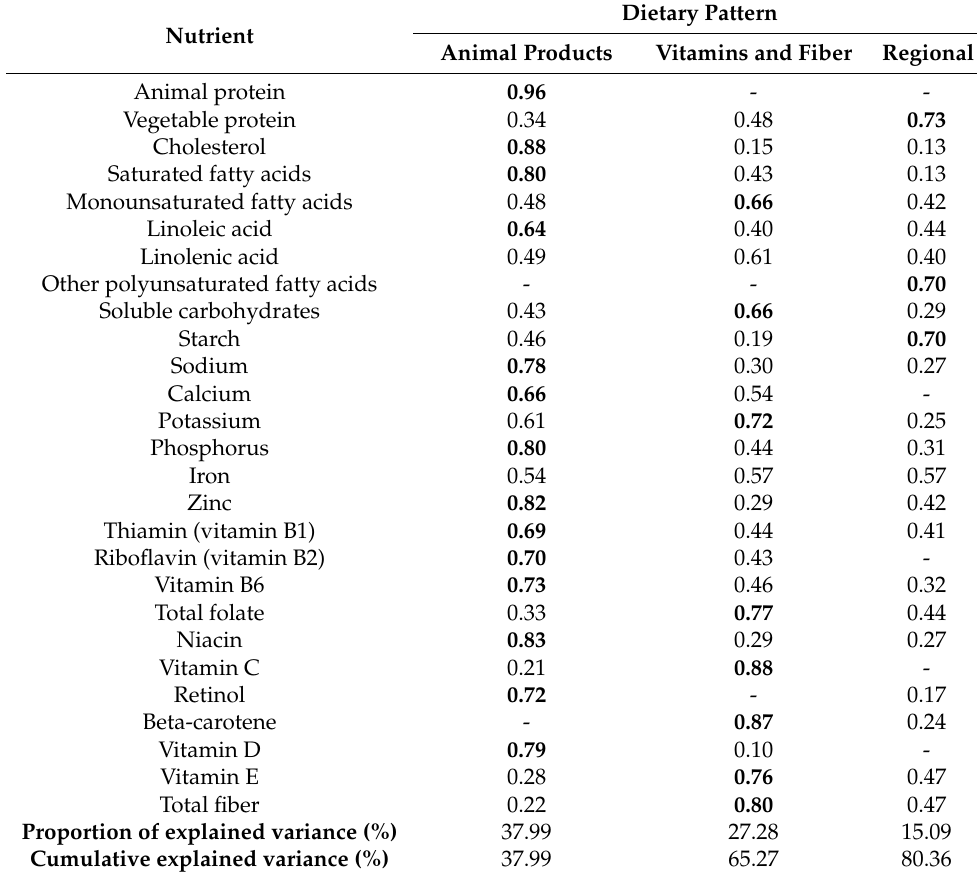
Table 3. Factor loading matrix 1 and explained variances for the three major dietary patterns identified by principal component factor analysis on baseline nutrient information. Italy,